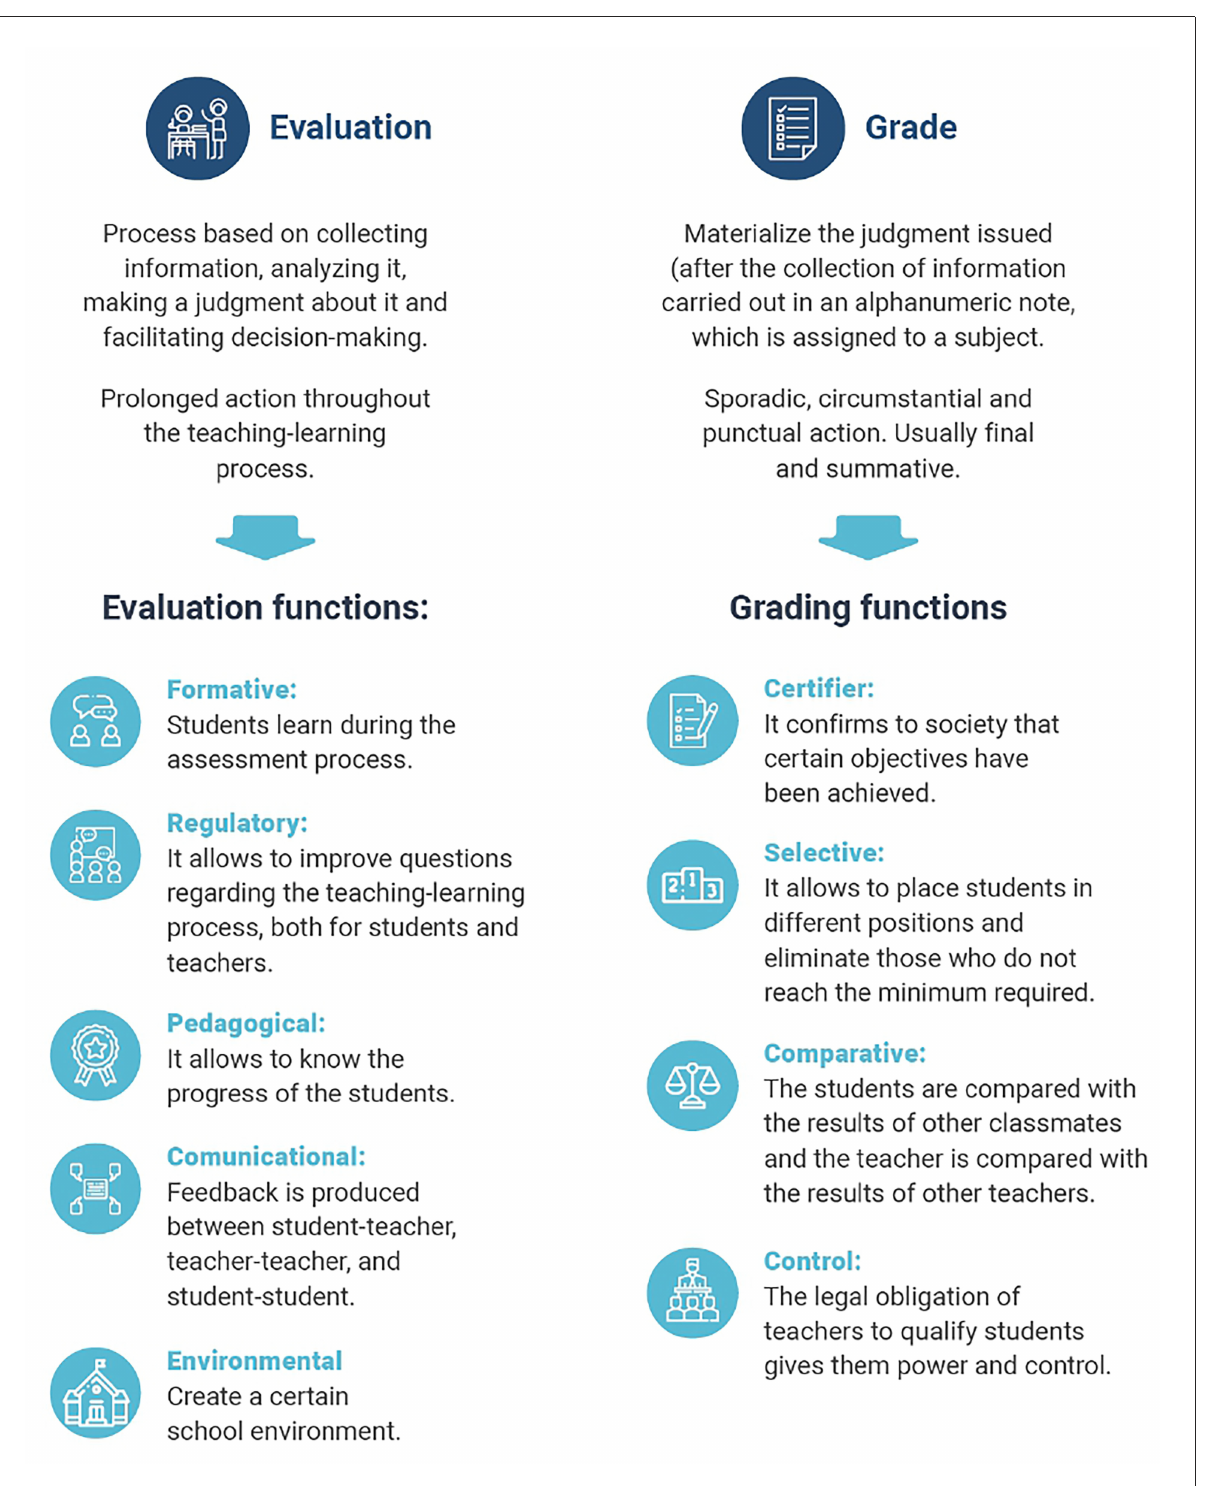
FIGURE1 Evaluating and grading process. Adapted from Hamodi et al.